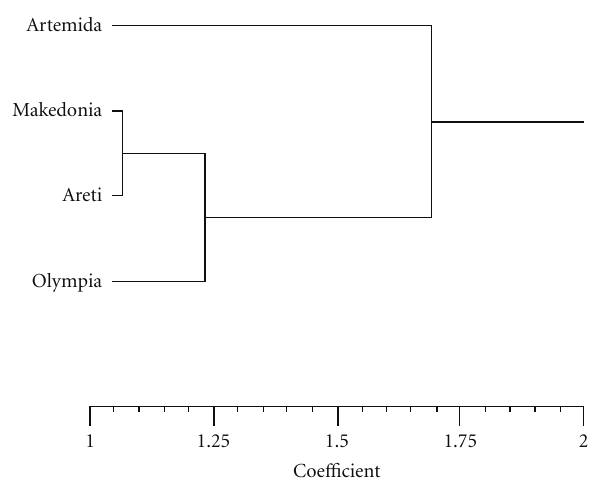
Figure 2: Dendrogram produced by cluster analysis based on DIST (average taxonomic distance) matrix for cultivars.